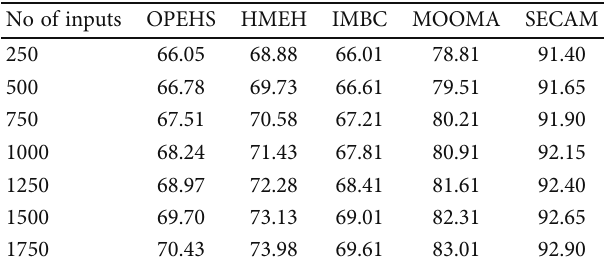
Table 4: Comparison of acceptance tests.